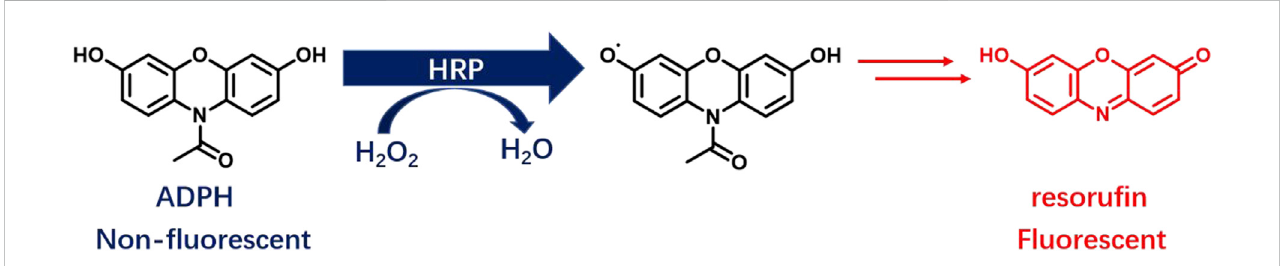
FIGURE 1 Scheme of the oxidative transformation of ADPH to resoru fi